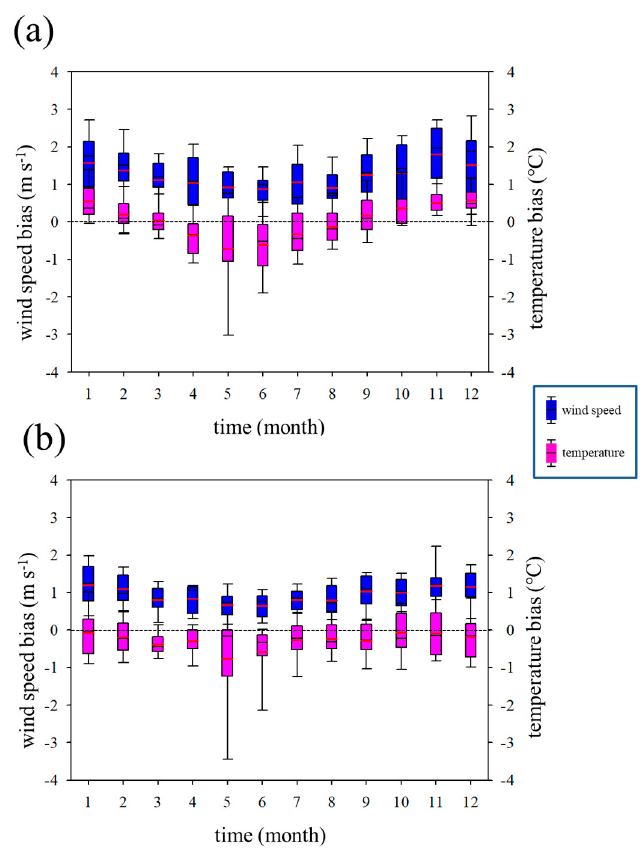
Figure 11. Monthly MBEs of wind speeds and temperatures predicted by LDAPS at the Rc AWSs. The LDAPS grid point closest to a comparison AWS is located at sea in ( a ) and land in ( b ).